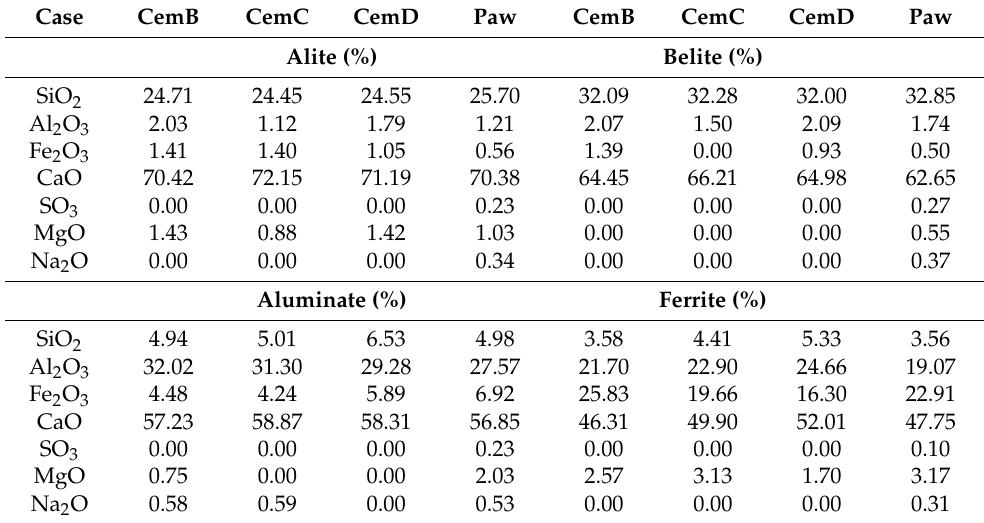
Table 8. Chemical compositions of the cement compounds reported by Le Saoût and Paweł [16,17].